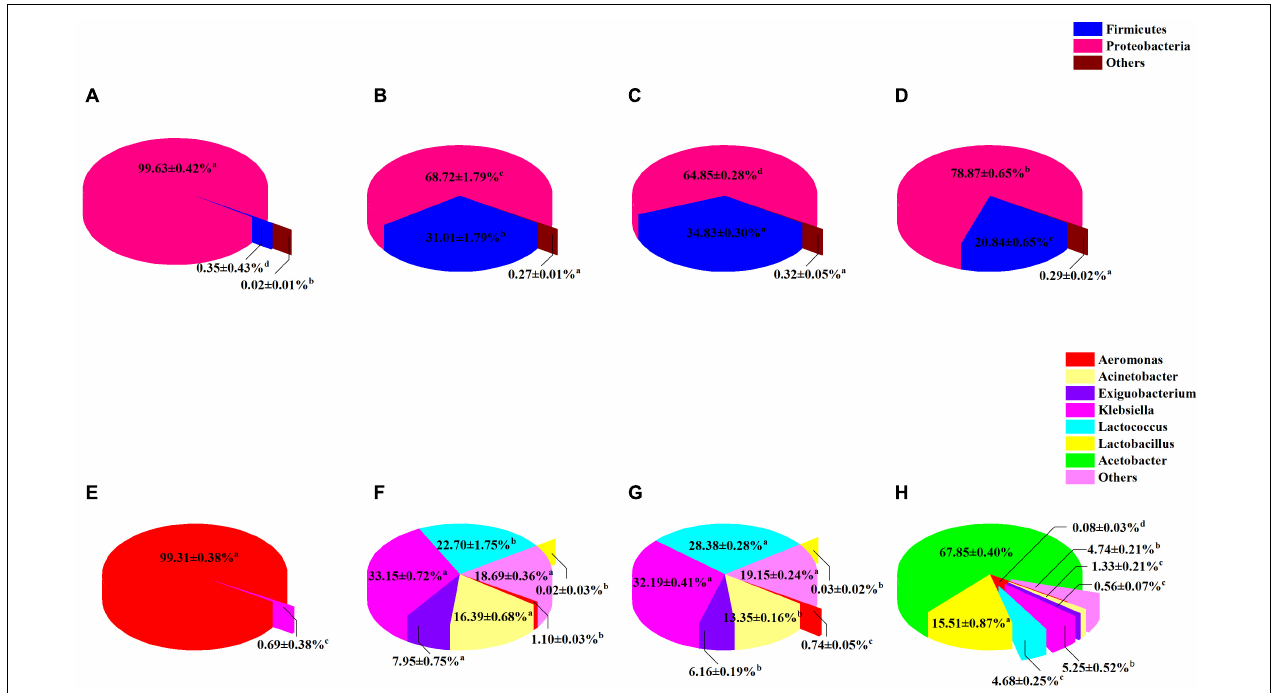
FIGURE 6 | Distribution of sour porridge microbiota composition of different fermentation periods at the phylum (A) NF-1; (B) NF-3; (C) NF-5; and (D) NF-7, and genus (E) NF-1; (F) NF-3; (G) NF-5; and (H) NF-7 level. The proportions of each phylum in NF-1, NF-3, NF-5, and NF-7 groups are as follows: